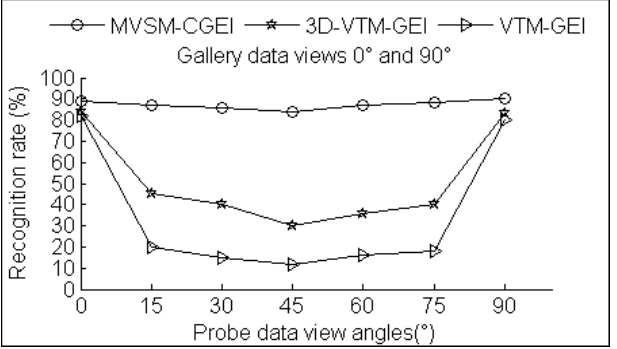
Figure 16. Comparison of recognition performance using different approaches.